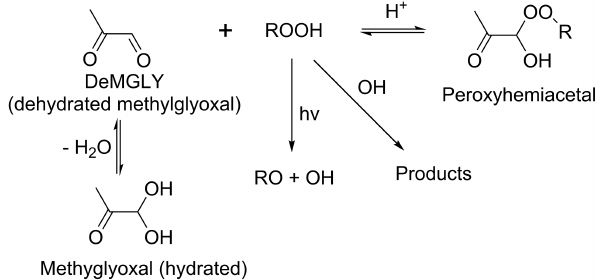
Figure 9. Peroxyhemiacetal